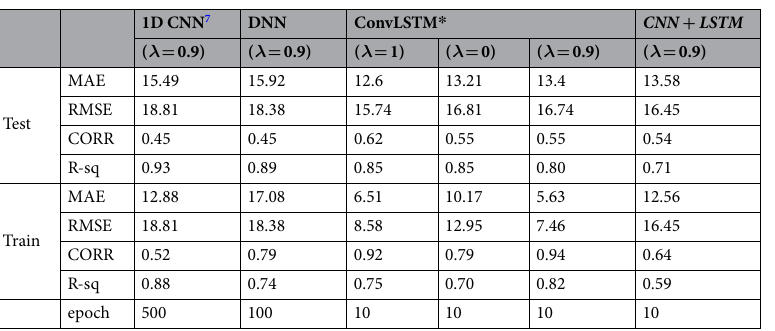
Table 10. Results of the Deep learning Age Prediction